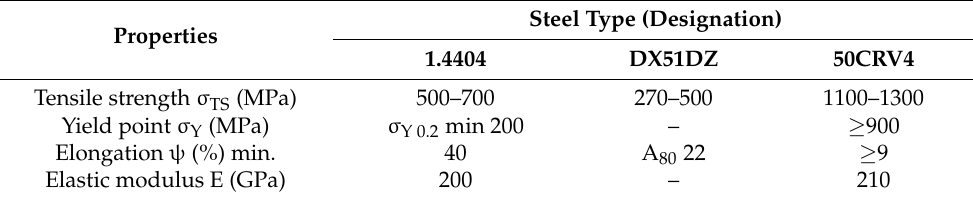
Table 1. Selected properties of adherends [18–20].